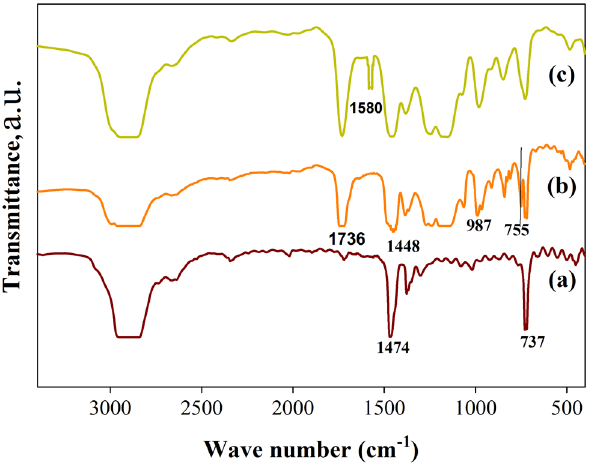
Figure 1: IRspectraof ( a ) LDPE, ( b ) LDPE - g - MMA,and ( c ) LDPE - g - MMA/Py, grafted at 10